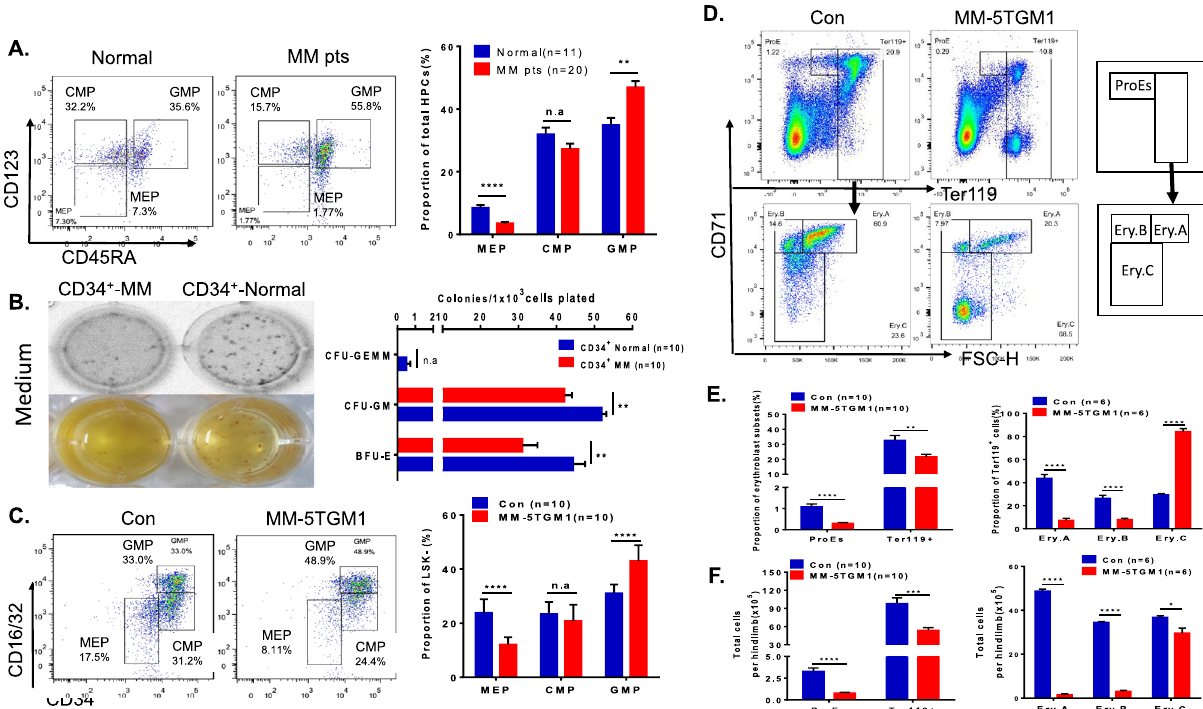
Figure 4. Erythroid differentiation of HSPCs was inhibited under the bone marrow microenvironment of MM patients and the 5TGM1 MM mouse model. ( A ) Flow plots (left) and a histogram (right) show the percentage of HSPCs in normal donors (n = 11) and NDMM patients (n = 20). The subset composition of HSPCs, including CMP (Lin − , CD34 + , CD38 + , CD123 lo , CD45RA − ), GMP (Lin − , CD34 + , CD38 + , CD123 lo , CD45RA + ), and MEP (Lin − , CD34 + , CD38 + , CD123 − , CD45RA − ), was determined. ( B ) Equal numbers of CD34 + cells from the BM of normal donors and NDMM patients were seeded in semisolid methylcellulose complete medium. The numbers of BFU-E, CFU-GM and CFU-GEMM colonies were calculated after 14 days of co-culture (upper). The means of the absolute numbers of colonies are shown (lower, n = 10 per group). ( C ) The subset composition of HSPCs, including CMP (Lin − , c-kit + , Sca-1 − , CD34 + , CD16/32 lo ), GMP (Lin − , c-kit + , Sca-1 − , CD34 + , CD16/32 hi ), and MEP (Lin − , c-kit + , Sca-1 − , CD34 − , CD16/32 − ), was determined in BM samples from MM-5TGM1 mice and control mice. ( D ) Erythroblast subsets were analysed by flow cytometry based on the expression of CD71 and Ter-119 as follows: ProE (CD71 + Ter-119 low ), Ery.A, Ery.B, and Ery.C (Ter-119 + ). ( E ) The proportion of different erythroblasts in BM from MM-5TGM1 mice and tumour-free control mice. ( F ) Absolute number of ProEs, Ter- 119 + , Ery.A, Ery.B and Ery.C in the BM of MM-5TGM1 mice and tumour-free control